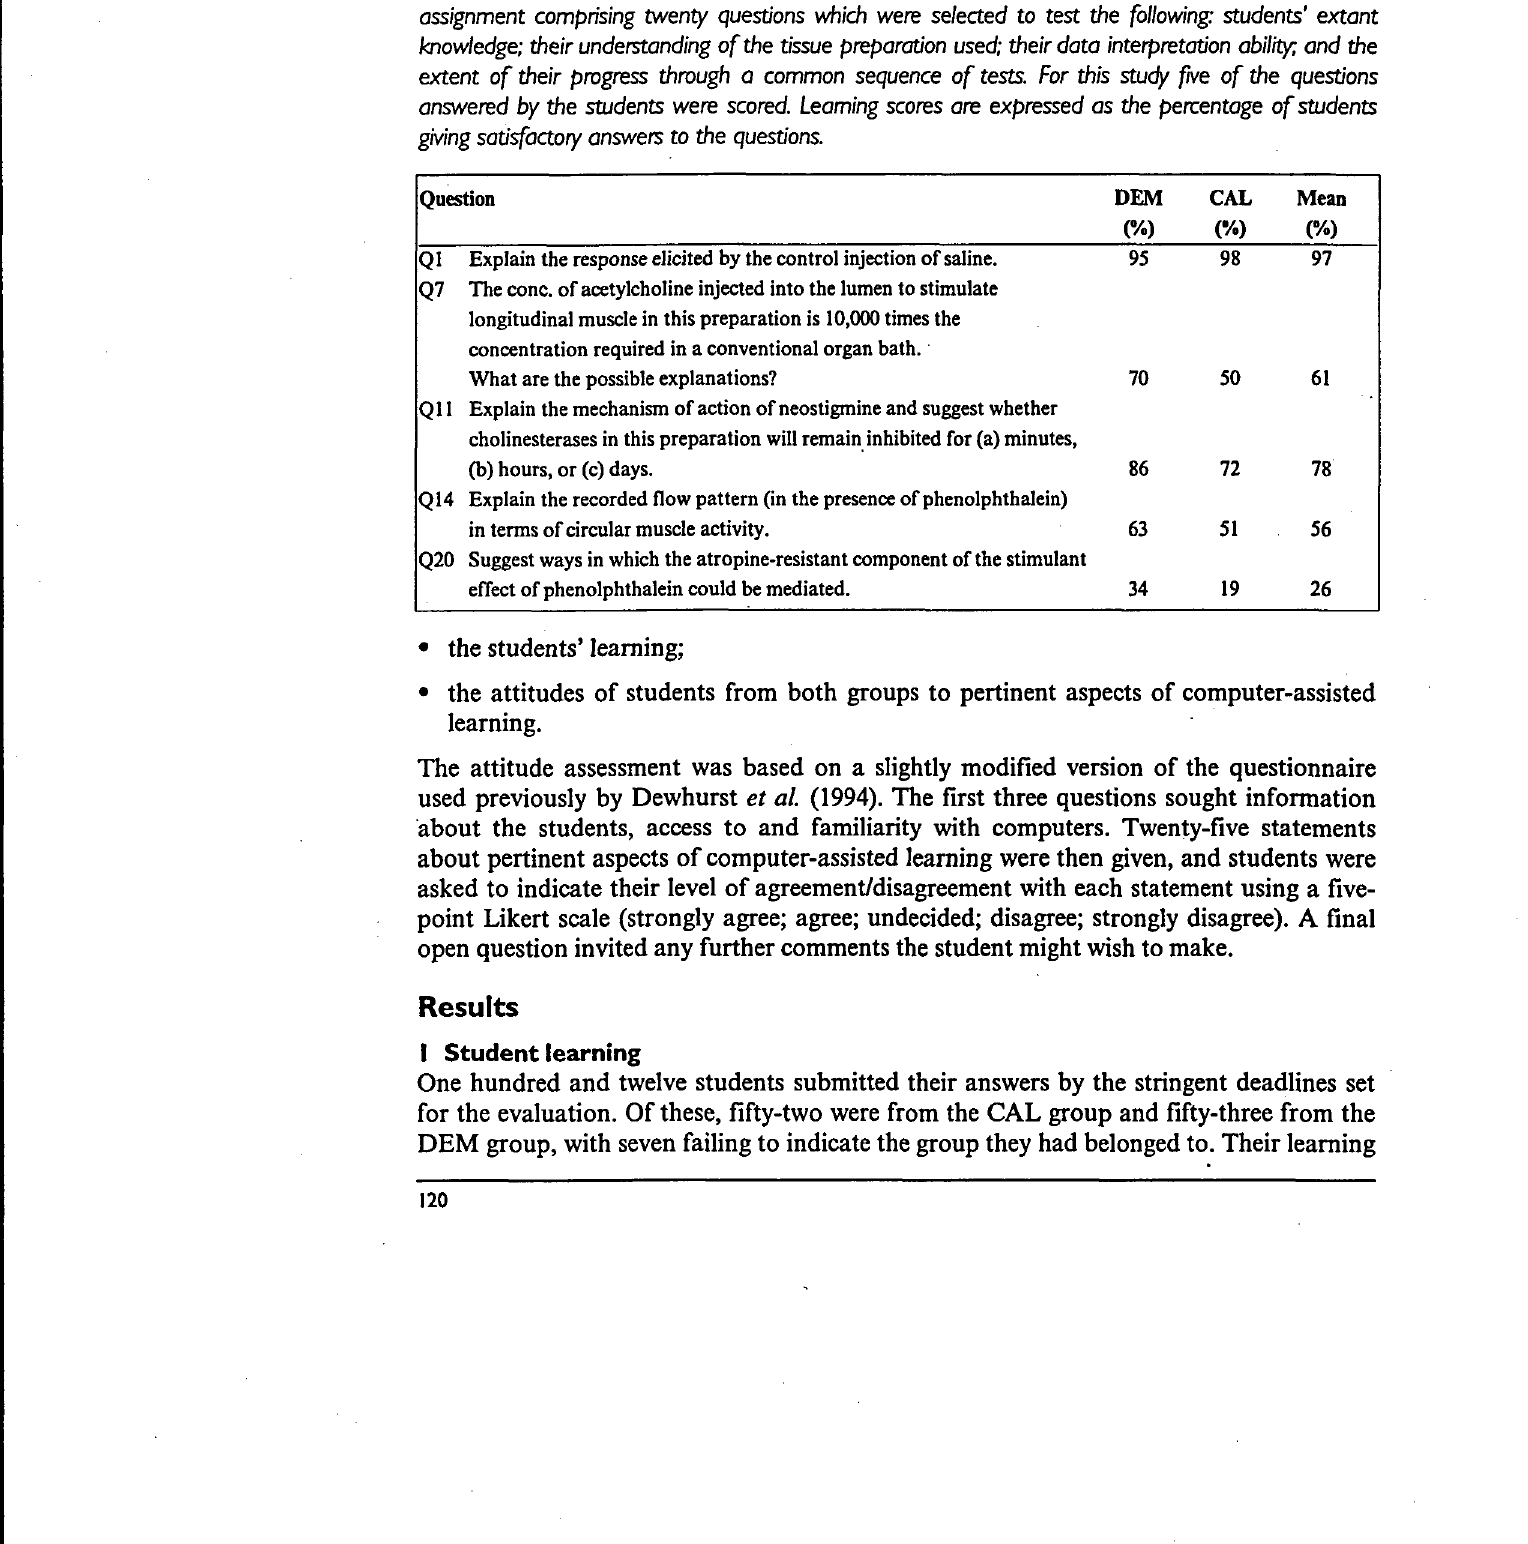
Table I: Comparison of the learning scores of students from the two groups ¡n the study. The DEM group (n = 52) received a tutored demonstration of a live laboratory practical and the CAL group (n = 53) received a computer simulation which allowed them to access typical results from a number of experiments performed on this preparation. Student learning was assessed using an assignment comprising twenty questions which were selected to test the following: students' extant knowledge; their understanding of the tissue preparation used; their data interpretation ability; and the extent of their progress through a common sequence of tests. For this study five of the questions answered by the students were scored. Learning scores are expressed as the percentage of students giving satisfactory answers to the